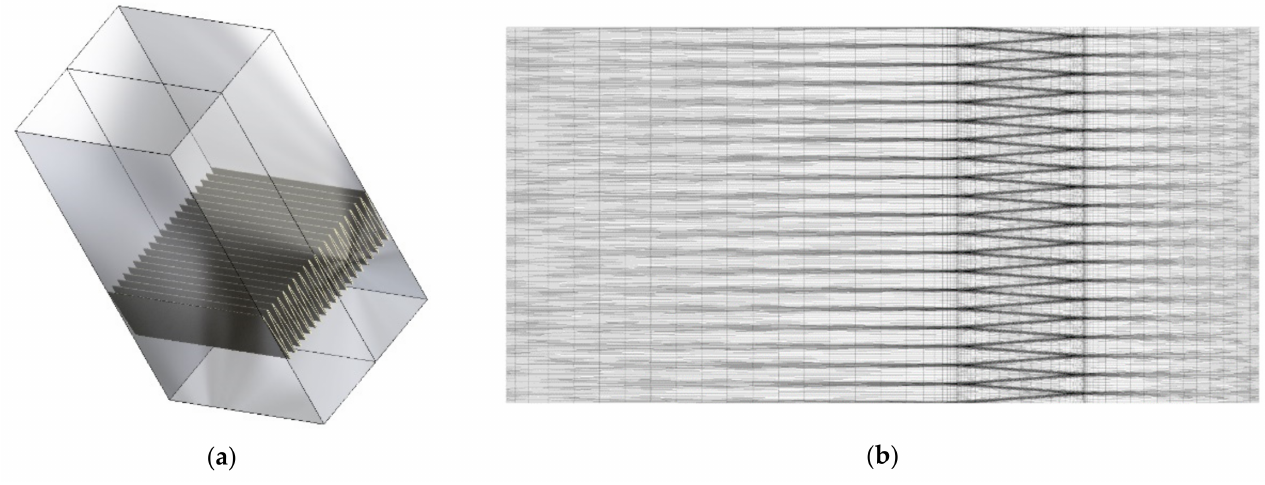
Figure 6. Simplified test geometry. ( a ) Scheme of computational domain; ( b ) Cross-section of computational